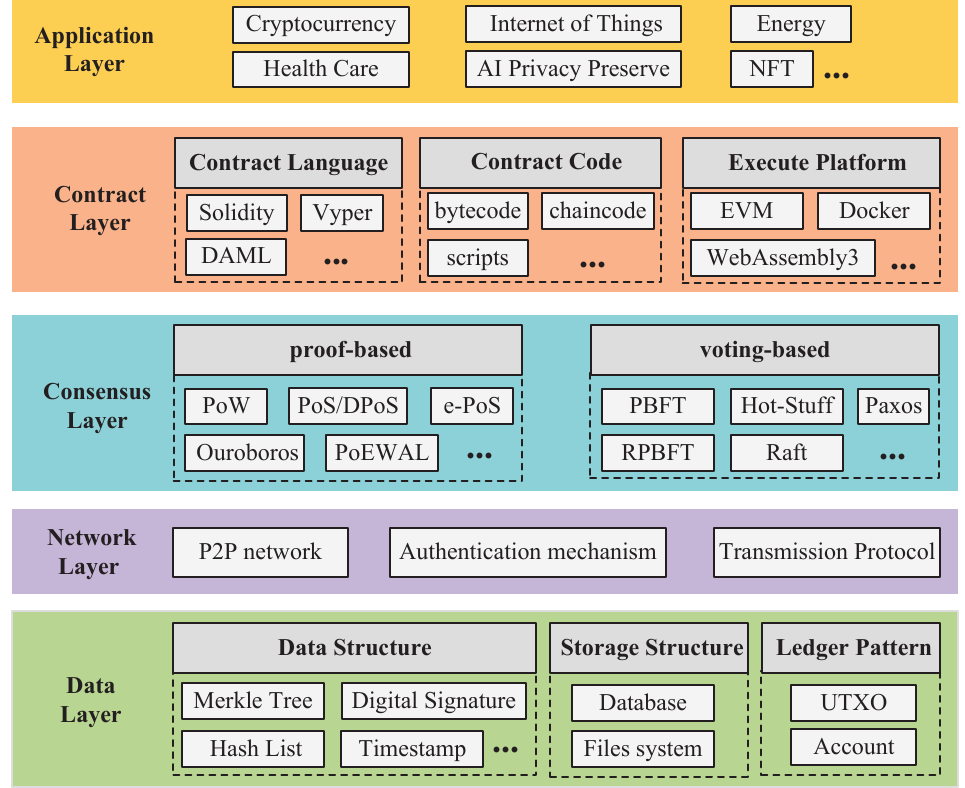
Figure 1. Blockchain architecture.